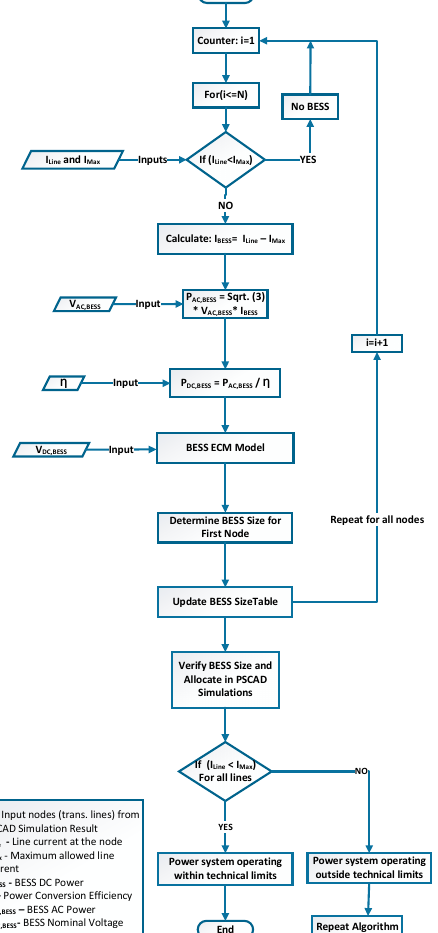
Figure 5. Battery sizing and allocation algorithm. ECM: equivalent circuit model. PSCAD: Power Systems Computer-Aided